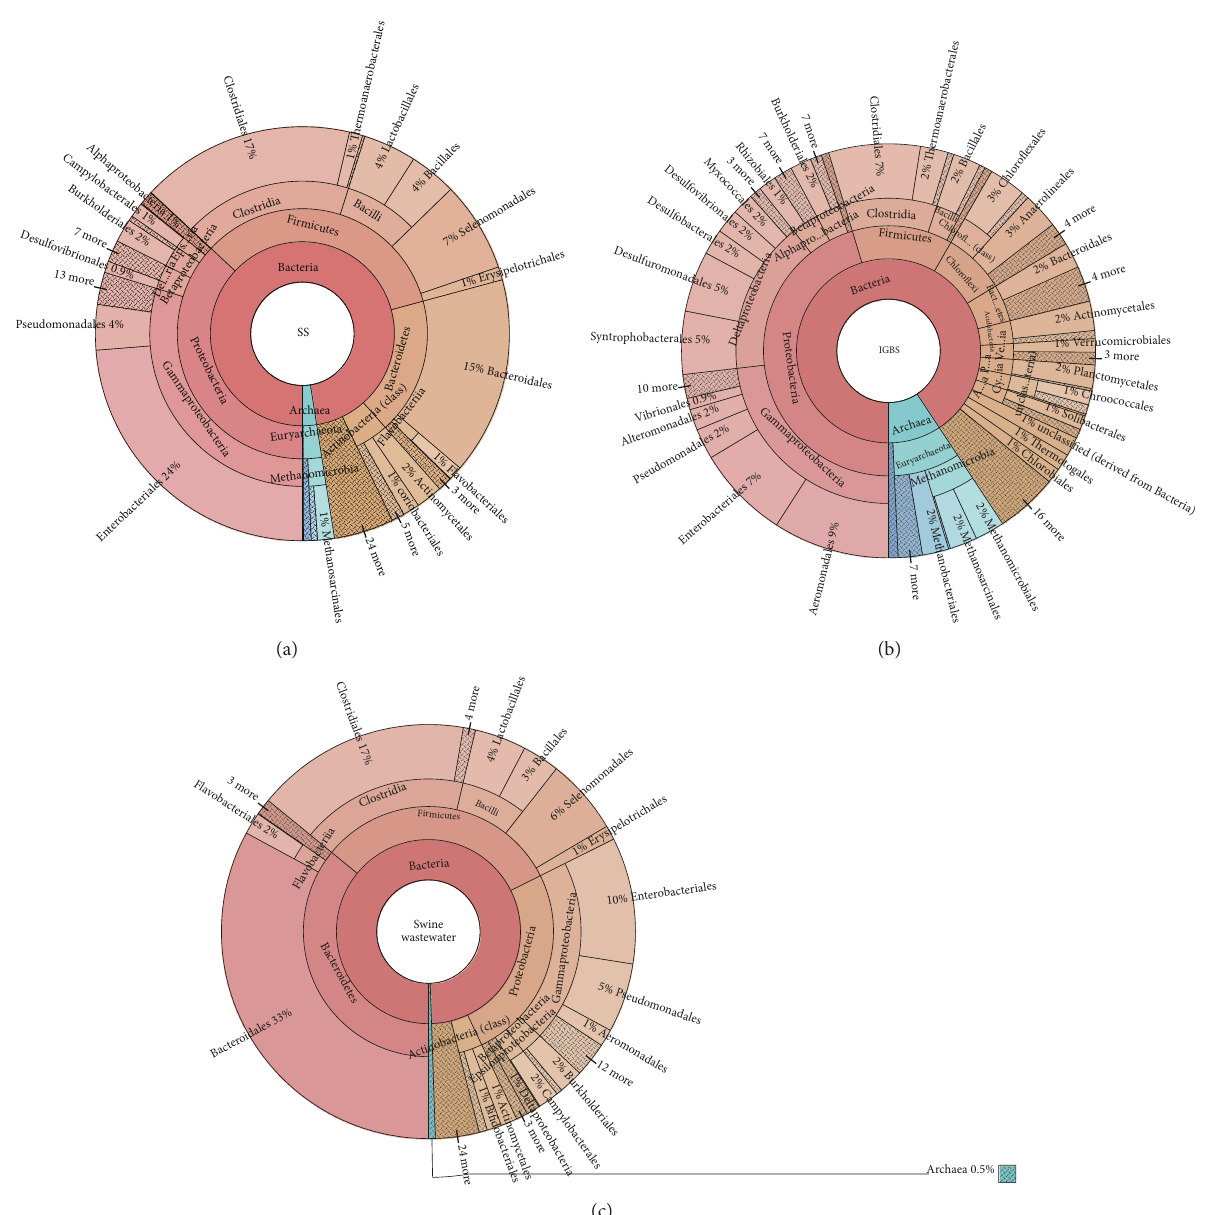
Figure 1: Summary of the microbial community profiles in the multilevel Krona diagrams. Krona plots visualizing taxonomic hierarchies of the microbial communities of (a) swine sludge (SS), (b) industrial granular brewery sludge (IGBS), and (c) swine wastewater.